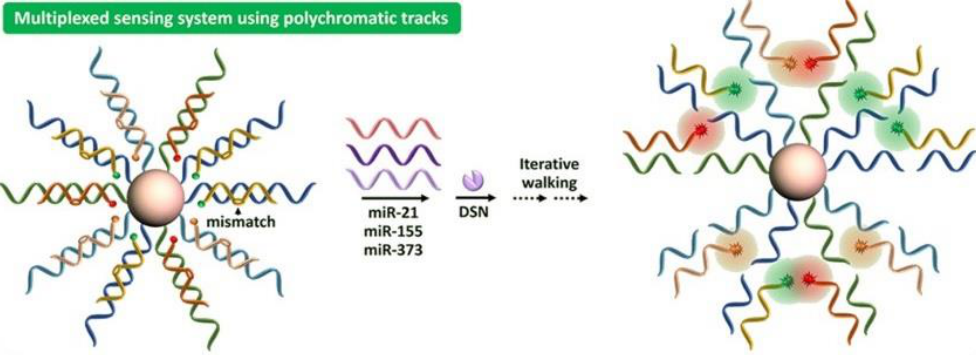
Figure 5. Schematic representation of the multiplexed sensing system using polychromatic tracks. Reprinted with permission from Ref. [73]. Copyright 2021, Elsevier.